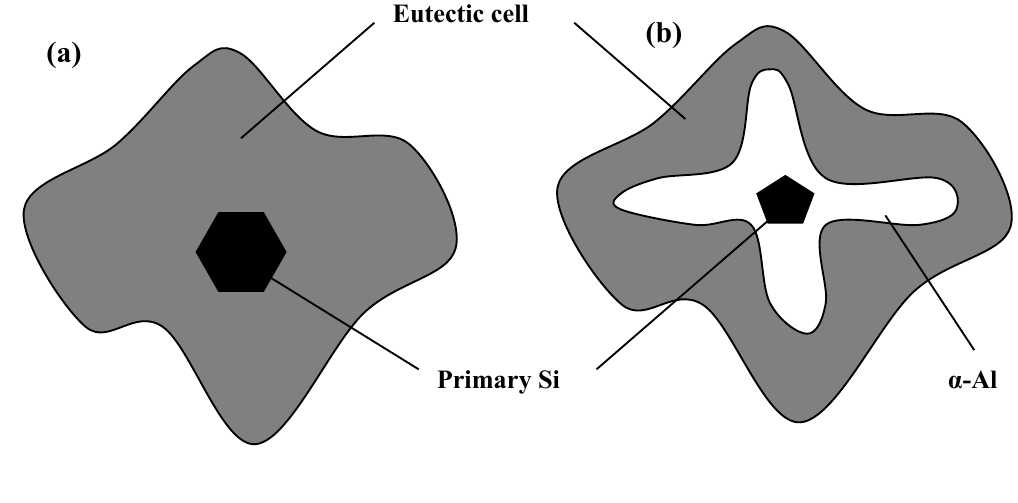
Figure 7. The structure evolving schematic of the macro-grains of Al-17%Si alloys: ( a ) unmodified alloys; ( b ) modified